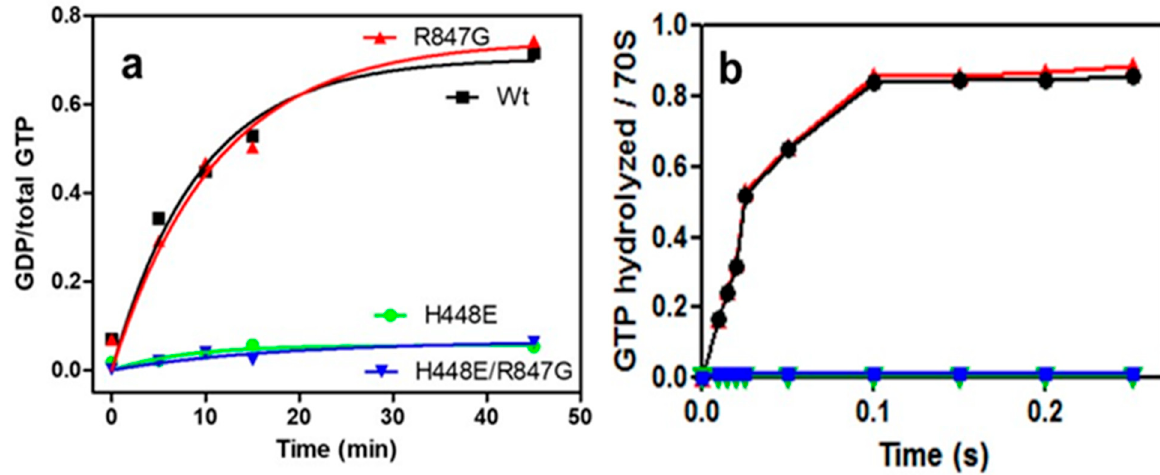
Figure 3. GTPase activity of IF2 wt and IF2 mutants. The kinetics of GTPase activities of IF2 wt (black), IF2 R847G (red), IF2 H448E/R847G (blue), and IF2 H448E (green) were analyzed ( a ) manually upon incubation at 37 °C for the indicated times in multiple turnover mode in the presence of ligand-free 70S ribosomes and ( b ) with a quench–flow apparatus in a single round hydrolysis mode upon formation of complete 70S initiation complexes. Experimental details can be found in Materials and Methods.